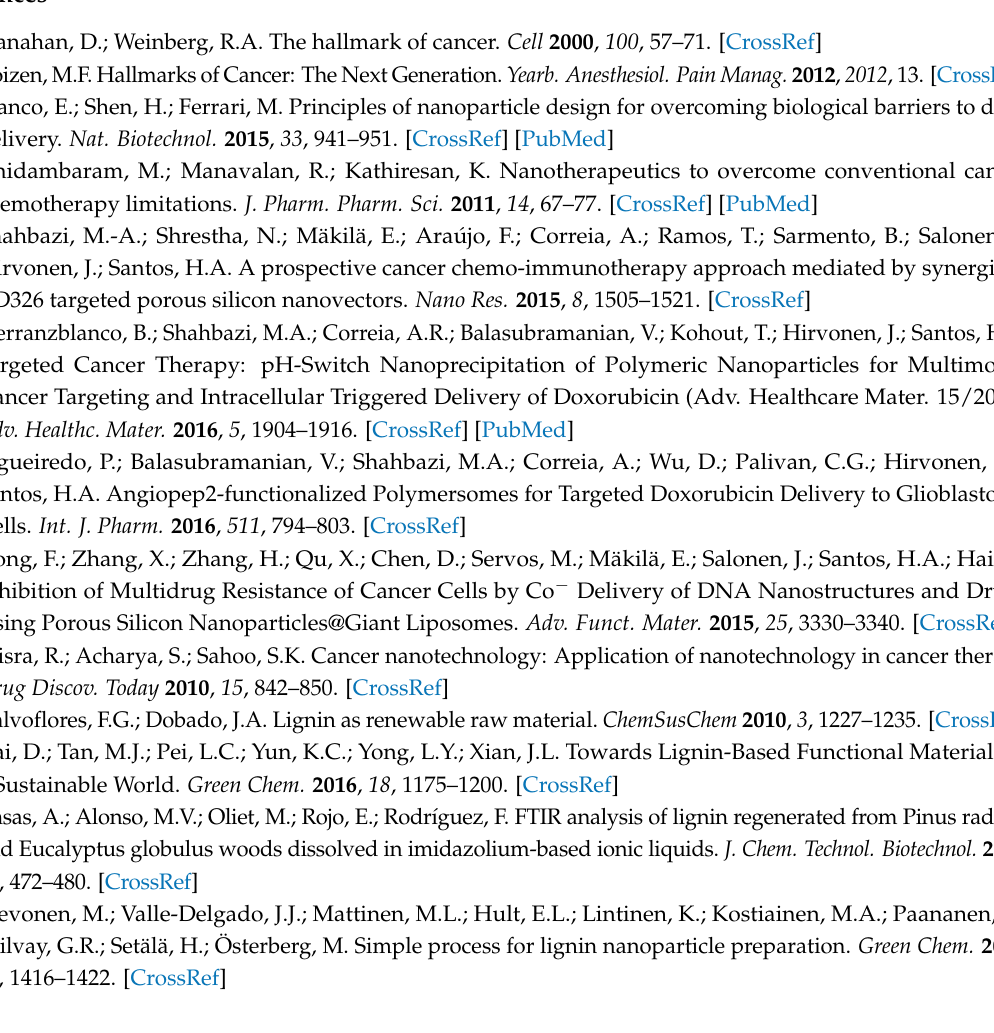
Table S1 Effect of different technique on average size, PDI, drug loading and Encapsulation efficiency of LNPs. Figure S1. TEM images of Fe 3 O 4 NPs. Figure S2. The preparation process of folic acid molecule graft for MLHNPs. Figure S3. FTIR spectra of LHNPs, MLHNPs and FA-MLHNPs. Figure S4. TEM images and XRD pattern of crystallization DOX after